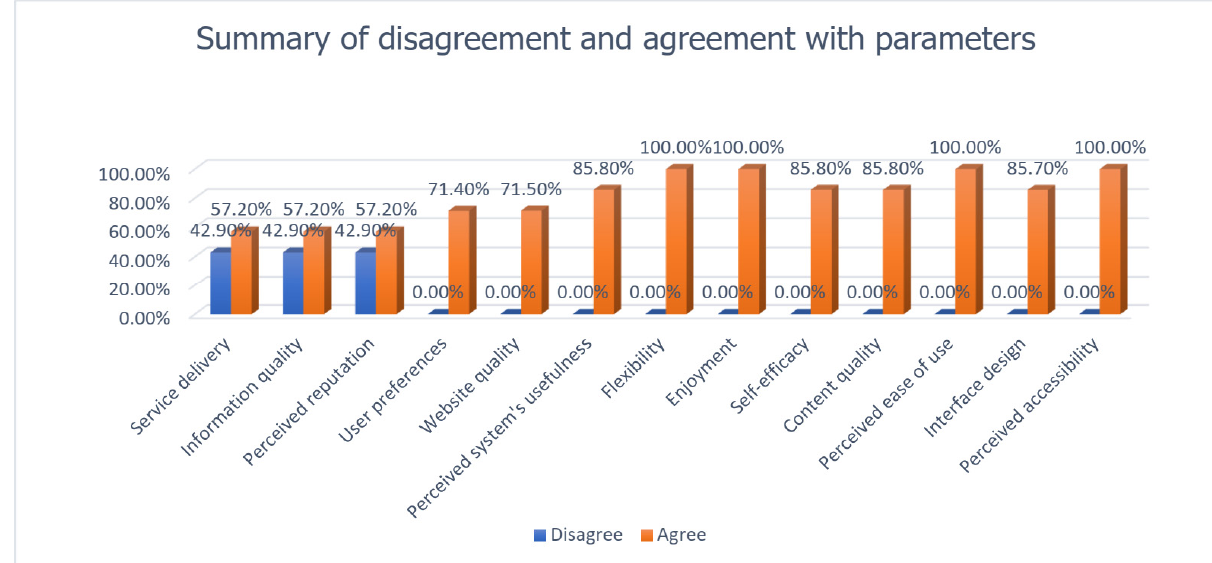
Figure 2. Summary of the total agreement and disagreement with parameters of iteration 2. Table 4. Summary of parameters of iteration